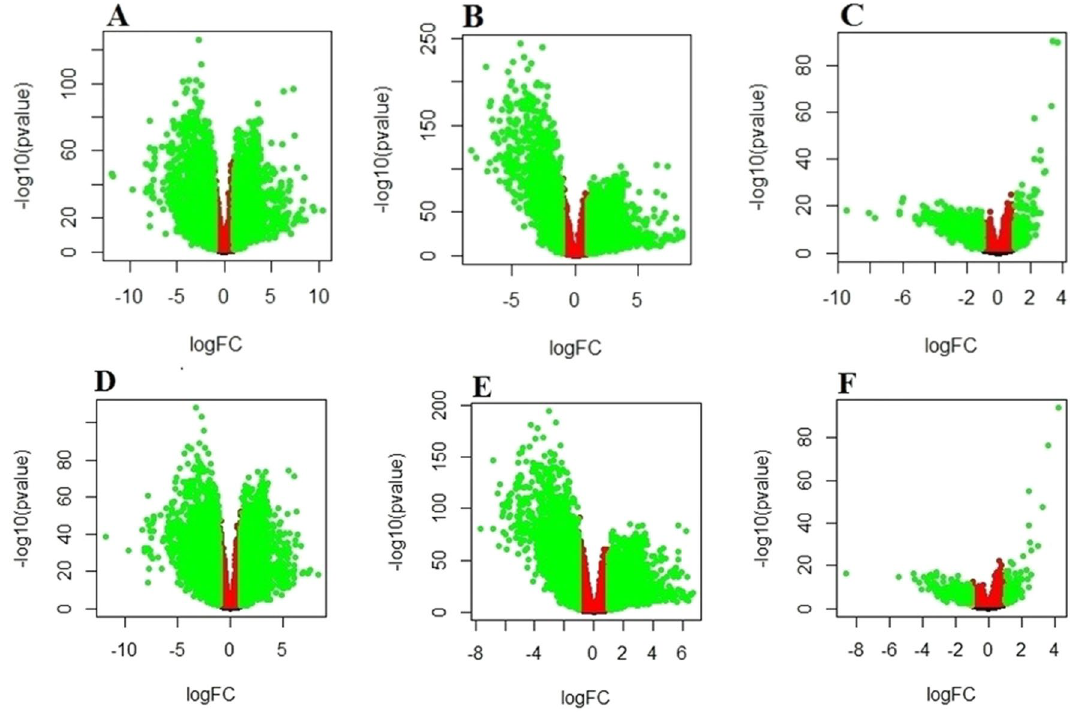
Figure 1. Volcano plats showed analysis of differential expressed genes (DEGs) between the normal compared with the tumors ( GATA3 -mutant and non-mutant). ( A ) Log 2 -fold change mutant and normal; ( B ) non-mutant and normal; ( C ) non-mutant and mutant; ( D ) Log 2 -fold change mutant and normal in ER-positive patients; ( E ) non-mutant and normal in ER-positive patients; ( F ) non-mutant and mutant in ER-positive patients. Green dots represent significantly DEGs (FDR < 0.05 and log FC >